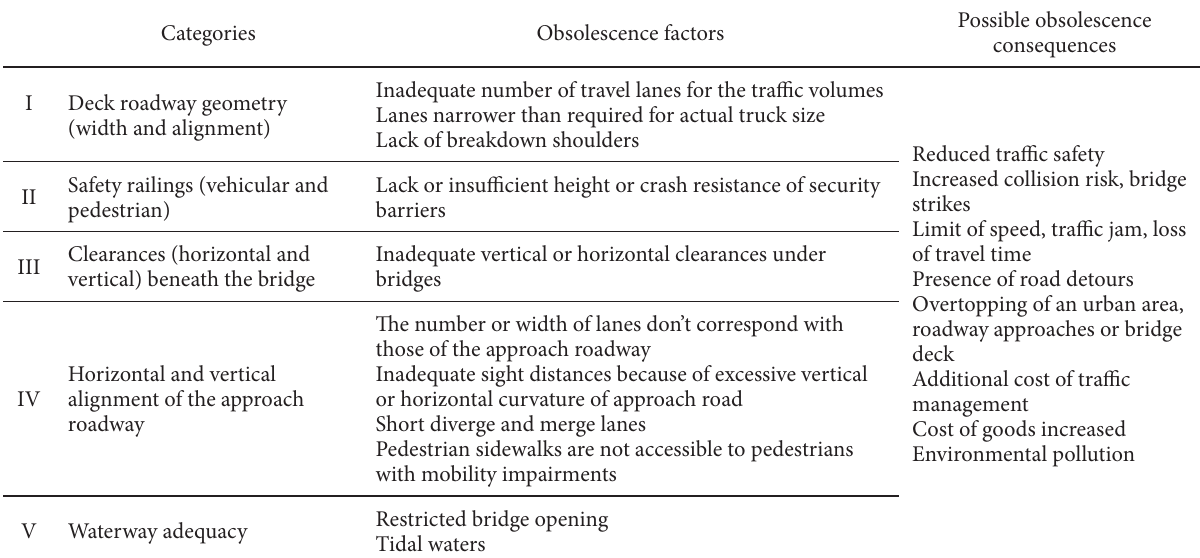
Table 1. Categories and factors of functionally obsolete bridges